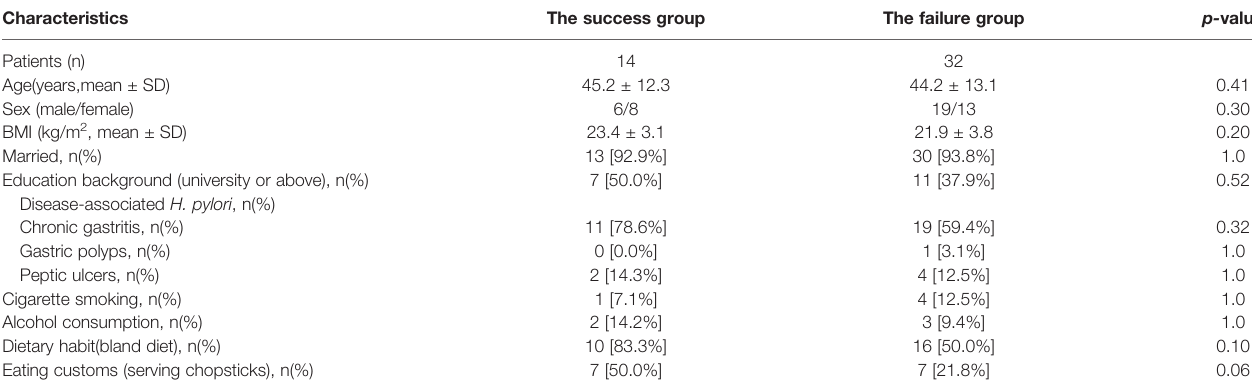
TABLE 2 | Demographic characteristics of patients who succeeded and failed to achieve eradication in the study